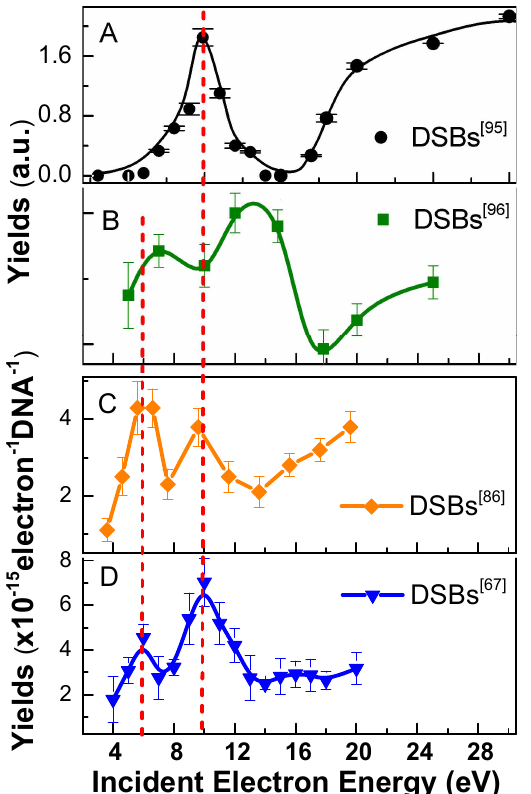
Figure 1. DSBs induced by LEEs below 30 eV in: ( A ) pGEM3Zf(−) plasmid DNA (3197 bps) from ref [95], ( B ) P14 plasmid DNA (6360 bps) from ref [96], ( C ) pGEM3Zf(−) plasmid DNA from ref [86], ( D ) pGEM3Zf(−) plasmid DNA from ref [67]. Dash lines indicate the energies of two prominent peaks around 6 and 10 eV.